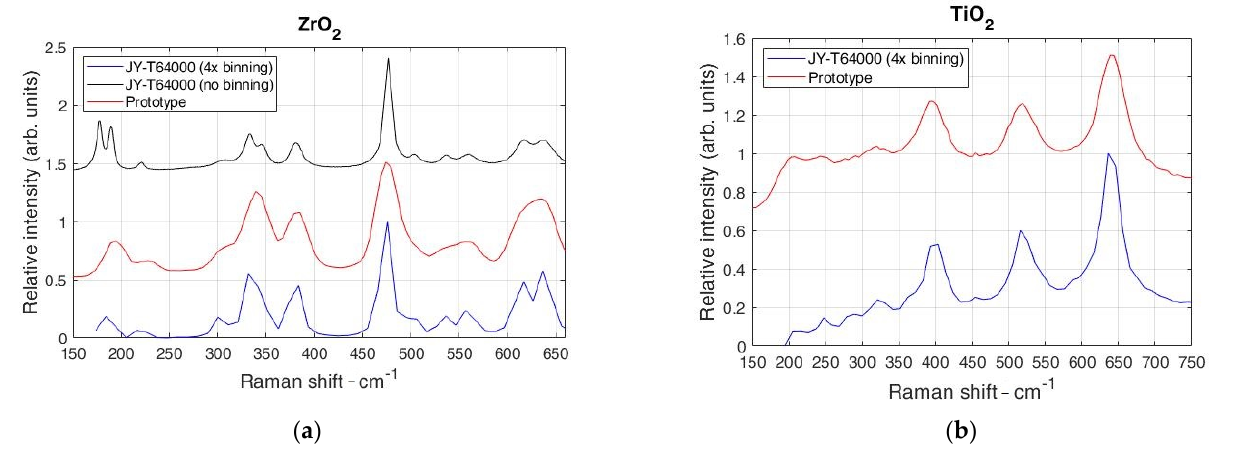
Figure 4. Comparison of the Raman spectra of ZrO 2 ( a ) and TiO 2 ( b ) using the proposed spectrometer with a reference spectrometer. Note that the reference spectrometer spectra without binning at ( a ) does not match spectral dispersion of prototype spectrometer; therefore, binning is used.